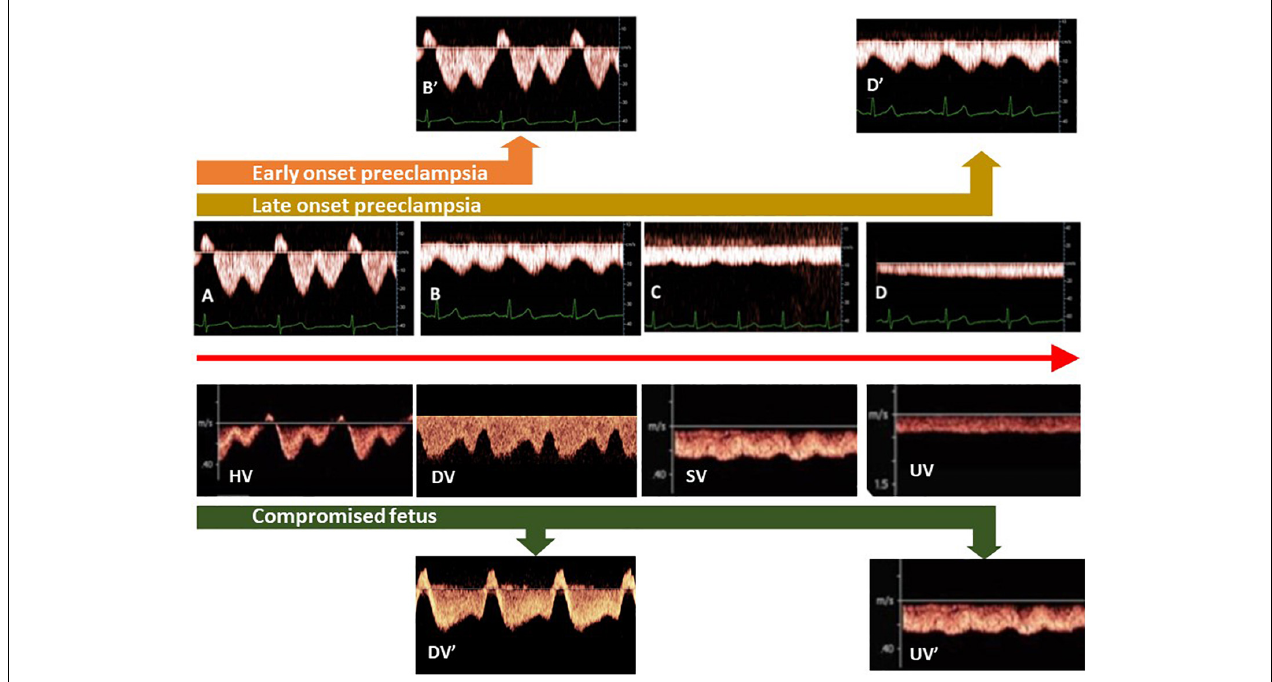
FIGURE 3 | Different types of venous Doppler waveforms in maternal and fetal circulations, varying between triphasic (A) , biphasic (B) , and monophasic (C) to flat (D) . In the fetus and non-pregnant adults, triphasic patterns are found close to the heart [hepatic veins (HV)], whereas flat patterns are present at distant locations [limbs, umbilical veins (UV)]. During uncomplicated pregnancy, HV patterns shift from (A–D) . In the clinical stage of preeclampsia with FGR, biphasic HV patterns become triphasic (orange arrow), whereas in term preeclampsia, monophasic patterns evolve to biphasic (brown arrow). In ductus venosus (DV) of FGR fetuses, a shift from biphasic to triphasic patterns occurs simultaneously with deteriorating fetal condition (green arrow). (SV: fetal splenic